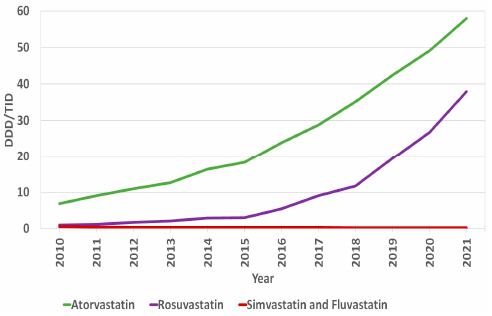
Figure 2. Annual sales of statins in DDD/TID according to types of statins.